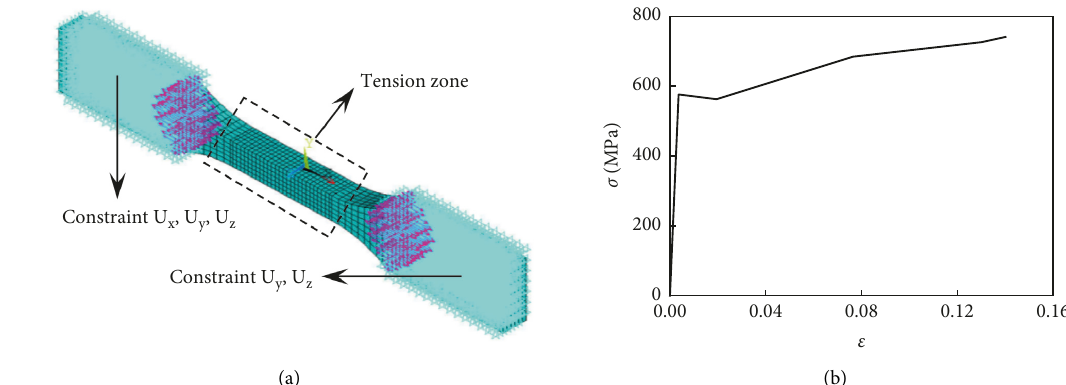
Figure 12: Configuration of the finite element model of the tested specimen. (a) Finite element mode. (b) Constitutive relationship of material.